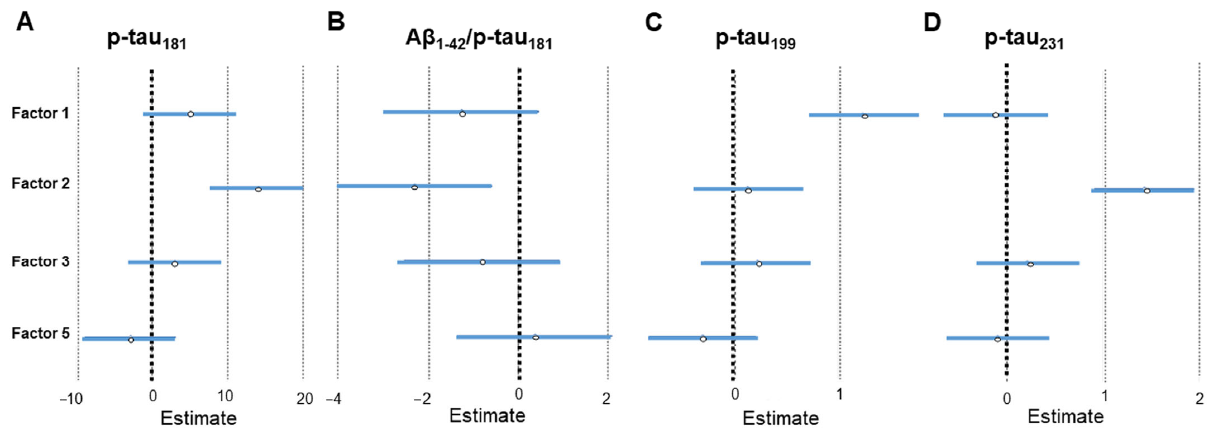
Figure 5. Association of CSF AD biomarkers – p ‐ tau 181 ( A ), A β 1–42 /p ‐ tau 181 ratio ( B ), p ‐ tau 199 ( C ), and p ‐ tau 231 ( D ) with CSF macro ‐ and microelement groups revealed by PCA. Effect sizes and 95% confidence intervals are given by linear regression analysis (statistically significant factors are considered those represented with horizontal lines that do not intersect with the vertical line at 0). Factor 1; CSF As, Ba, Ca, Co, Cu, Fe, K, Mg, Mn, Na, Ni, S, Se, Sr, Tl, and Zn; Factor 2; CSF Al, Cd, and Pb; Factor 3; CSF B and Li; Factor 5; CSF Hg and Mo.